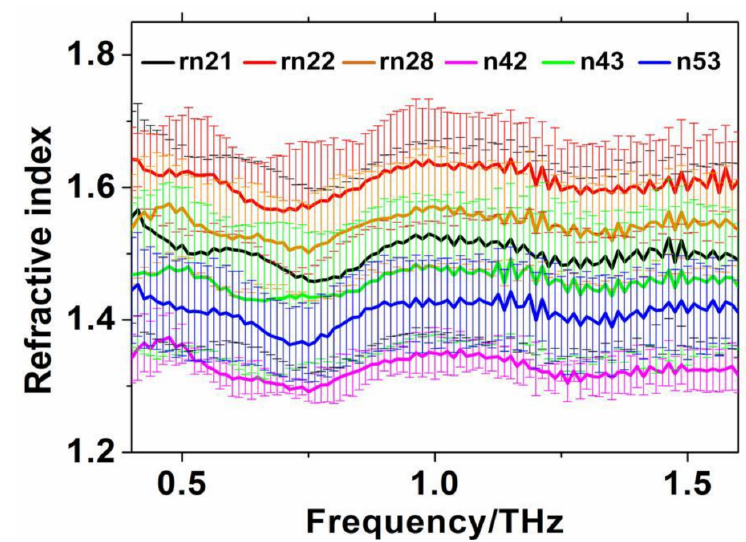
Figure 3. Refractive index of the proteins rn21, rn22, rn28, n42, n43 and n53 for samples with a concentration of 2.0 µ g/ µ L and a quantity of 8 µ g. Reprinted from Ref. [174].